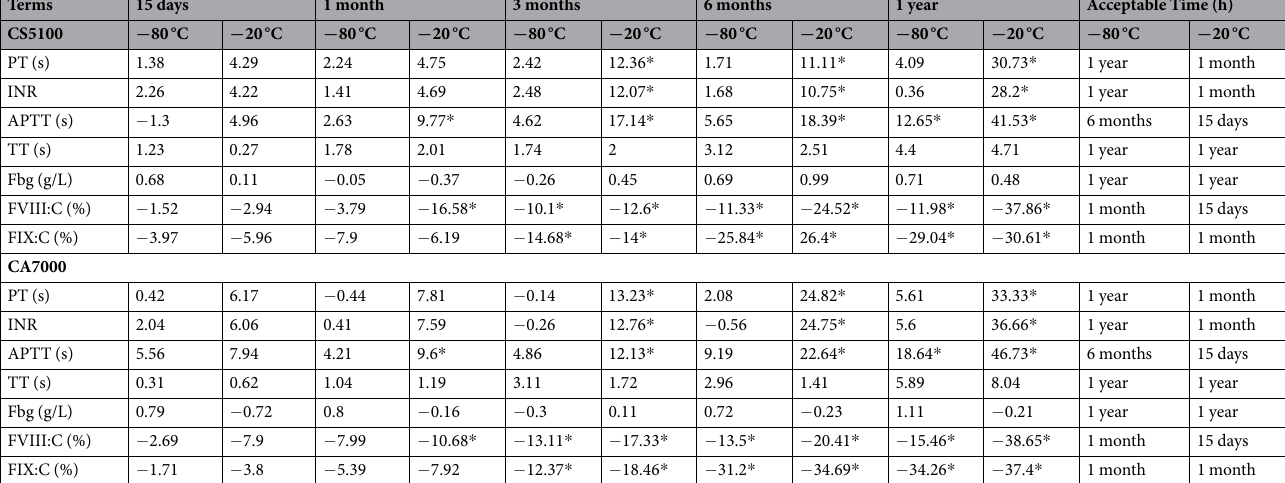
Table 2. Mean percent changes of PT/INR, APTT, Fbg, TT, FVIII:C, and FIX:C detected by the CS5100 and values. * Changes of > 10% in individual samples occurred in > 25% of samples.